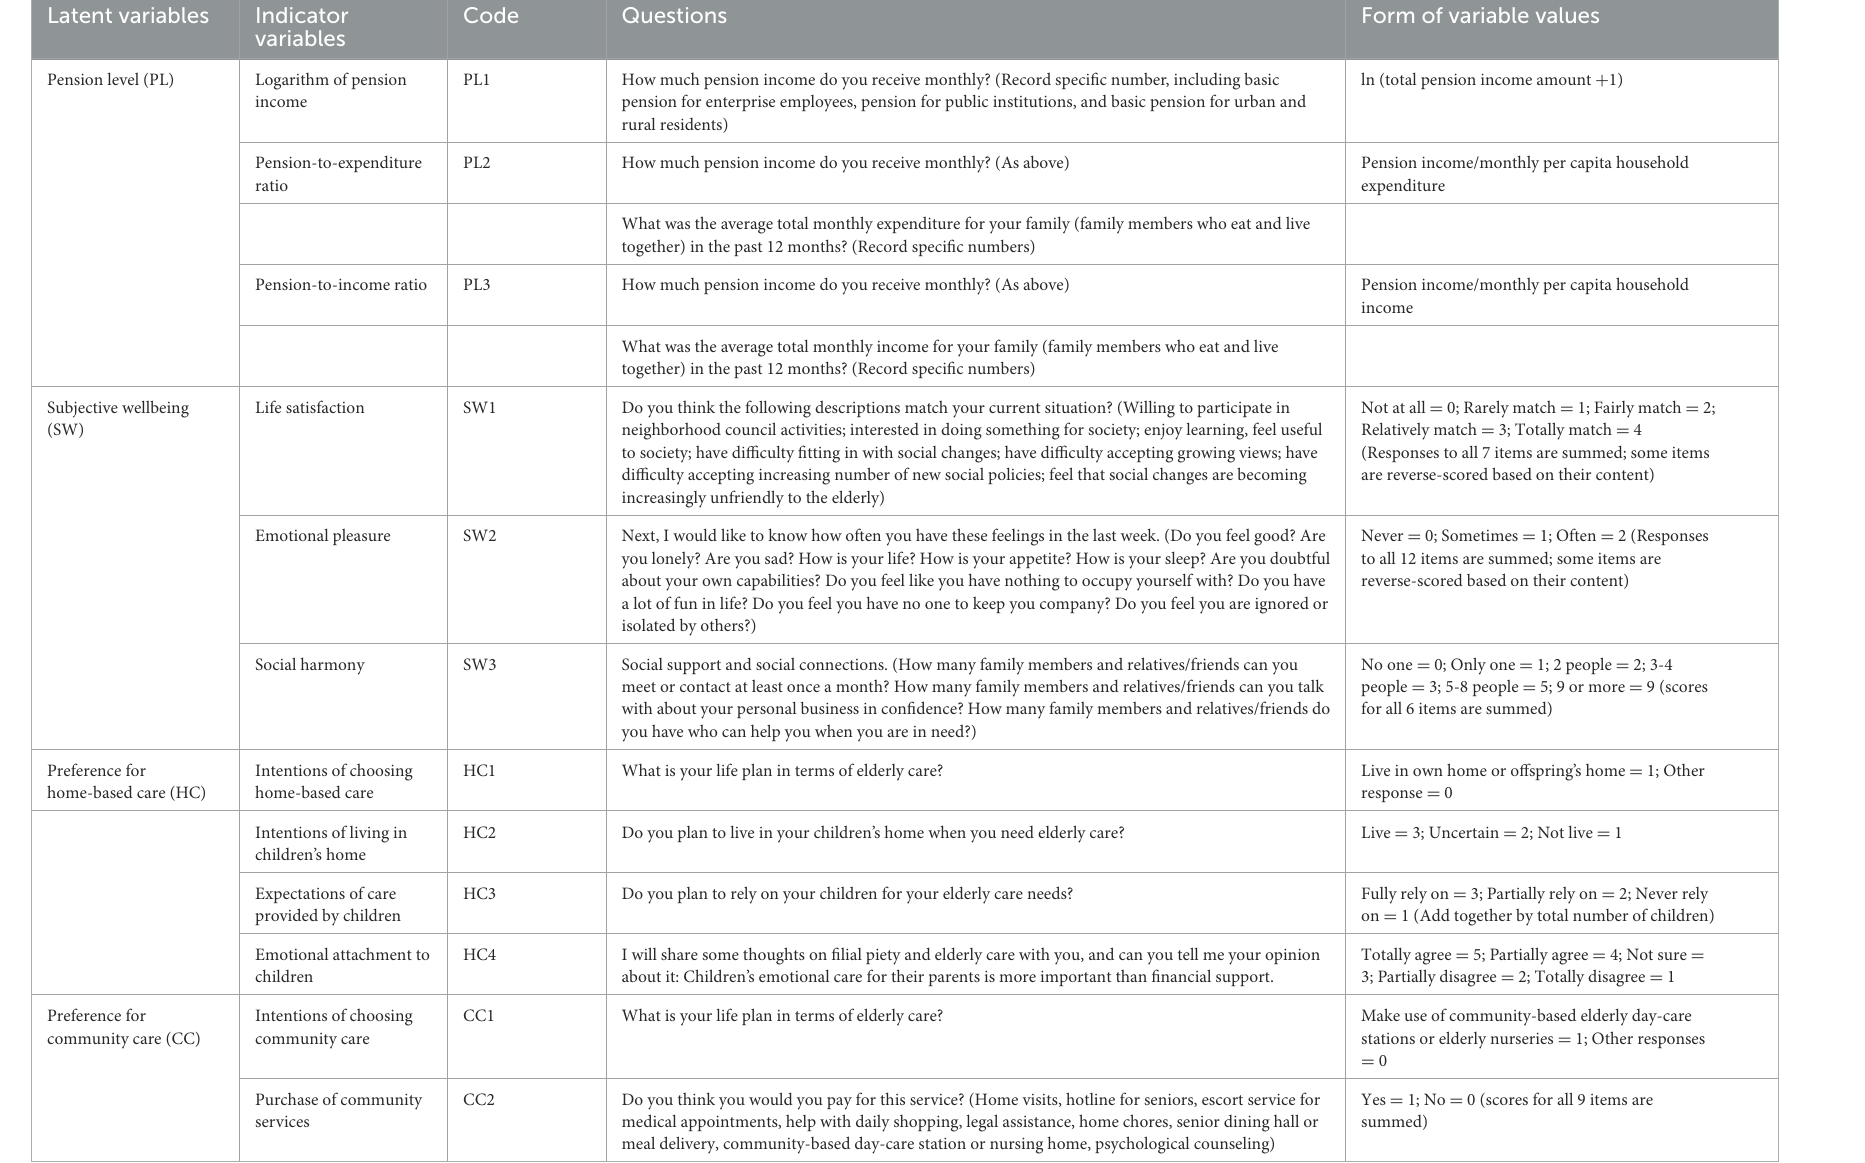
TABLE 1 Selection and measurement of